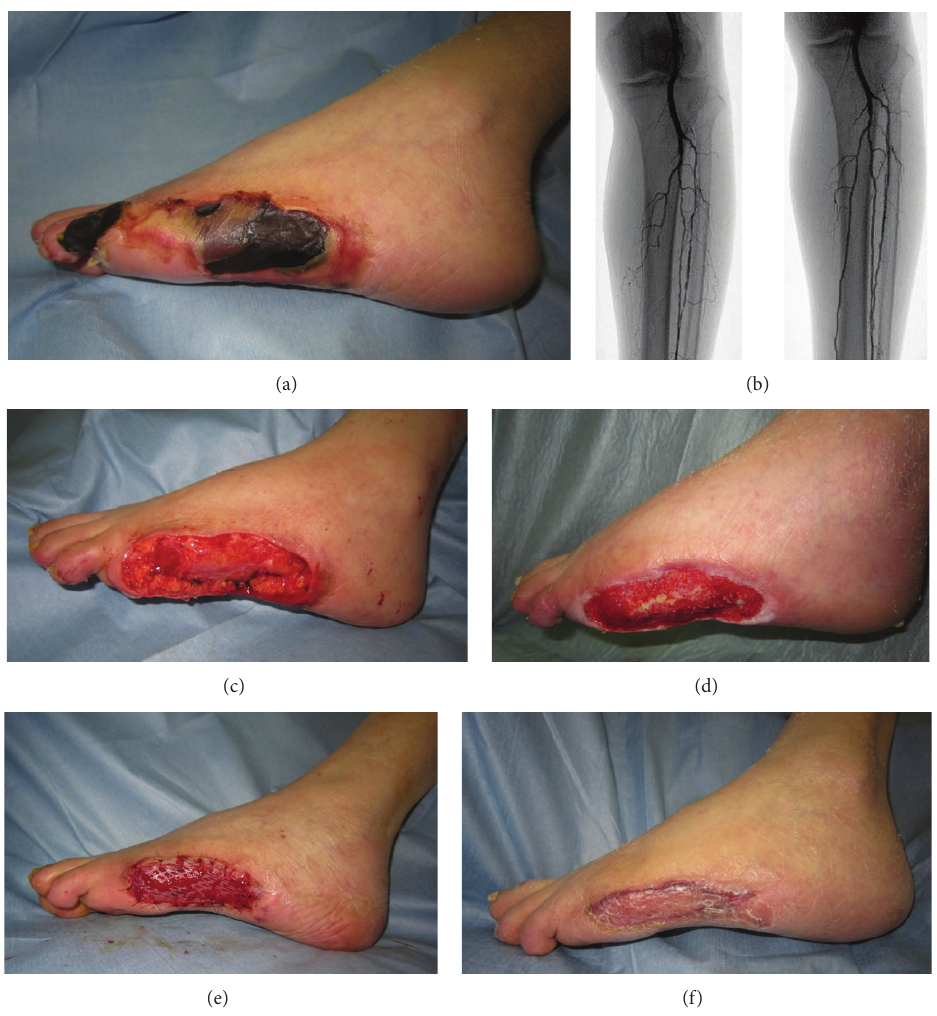
Figure 3: (a) Findings at first visiting our hospital: gangrene of the left 4th toe and skin necrosis of the lateral foot were observed. (b) Angiographic findings of the leg (left: before EVT; right: after EVT): occlusion of the left posterior tibial artery and stenosis of the anterior tibial artery and peroneal artery were observed; therefore, the 3 branches were dilated with a balloon. (c) Findings immediately after amputation of the left 4th toe and debridement: the left 4th toe was amputated at the metatarsal shaft, and skin necrosis of the lateral foot was removed. (d) Finding at the end of NPWT treatment using the V.A.C. ATS therapy system was performed for 3 weeks, and granulation was observed. (e) Finding immediately after split-thickness skin grafting: a skin graft with PRP (platelet-concentration ratio: 5.1x) was performed. (f) Finding at 2.5 months after the